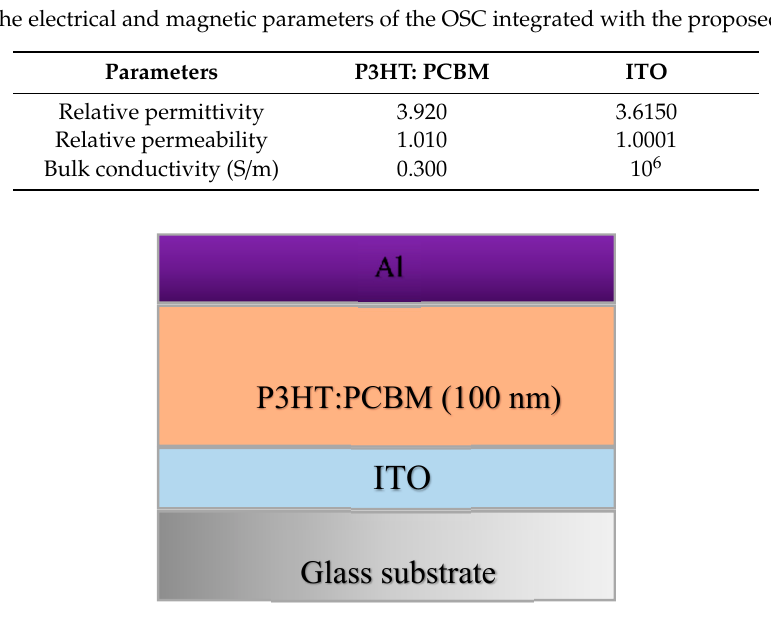
Figure 2. Schematic presentation of the proposed organic solar cell.